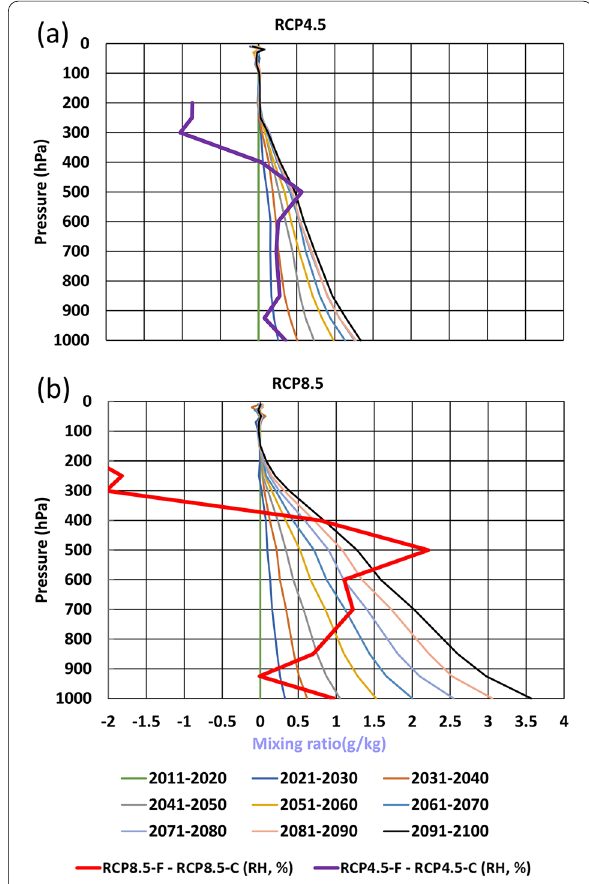
Fig. 11 Same as in Fig. 9, but is for r v of a RCP4.5, and b RCP8.5. The purple and red lines are RCP8.5‑F minus RCP8.5‑C and RCP4.5‑F minus RCP4.5‑C for relative humidity,